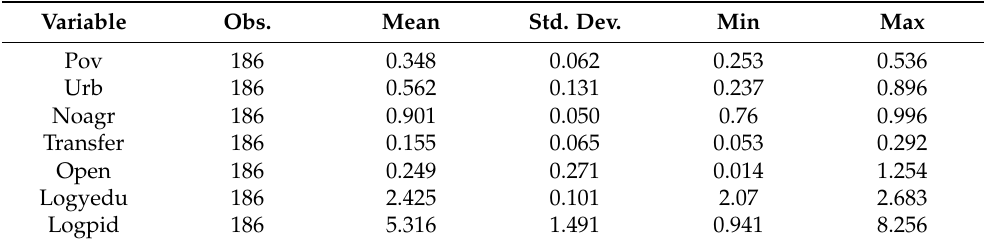
Table 3. Descriptive statistical analysis of